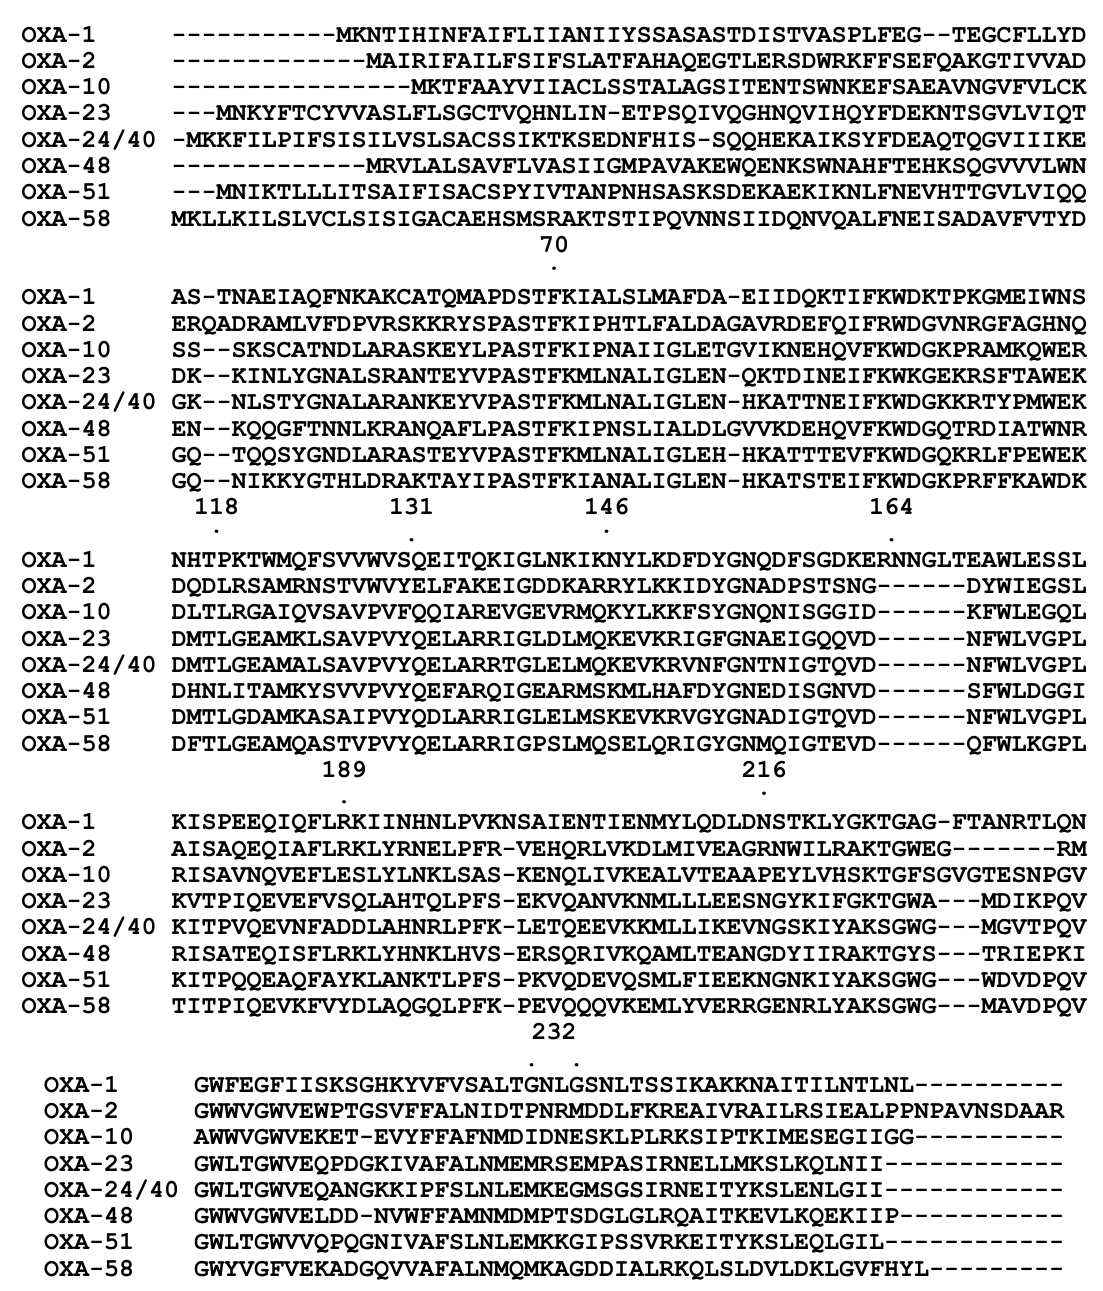
Figure 1. Amino acid alignment of seven Class D β-lactamases. Shaded in gray are motifs that are well conserved among this class of